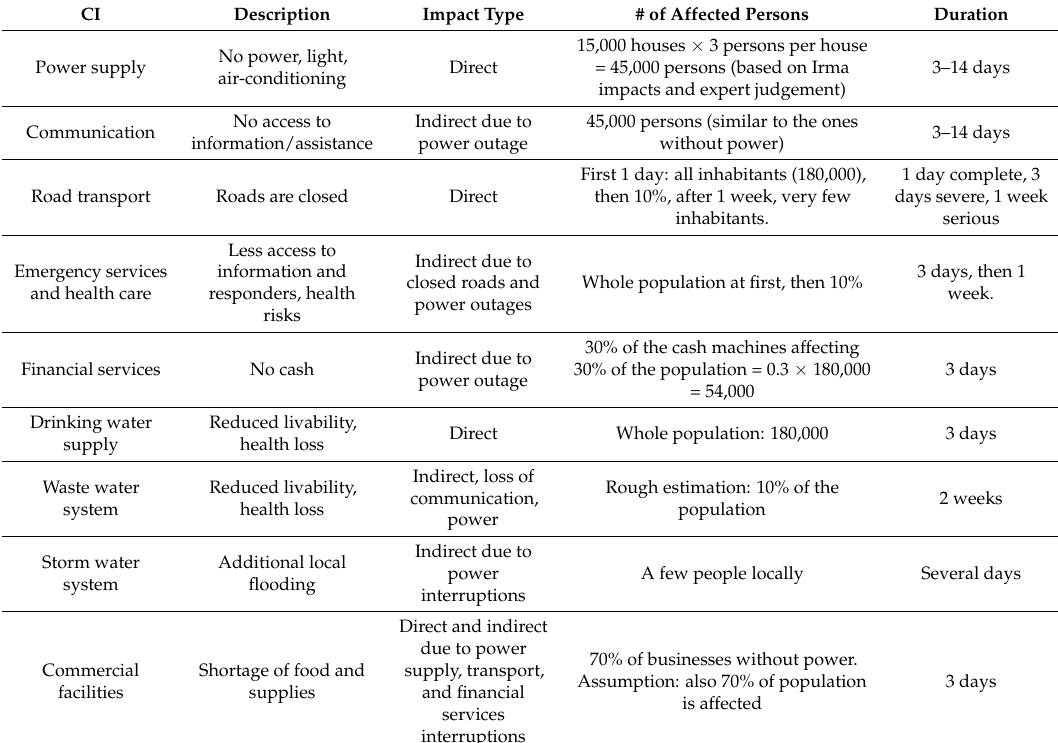
Table 1. Effect on livability of communities (source: based on the information provided, concrete assumptions were made and checked with experts).